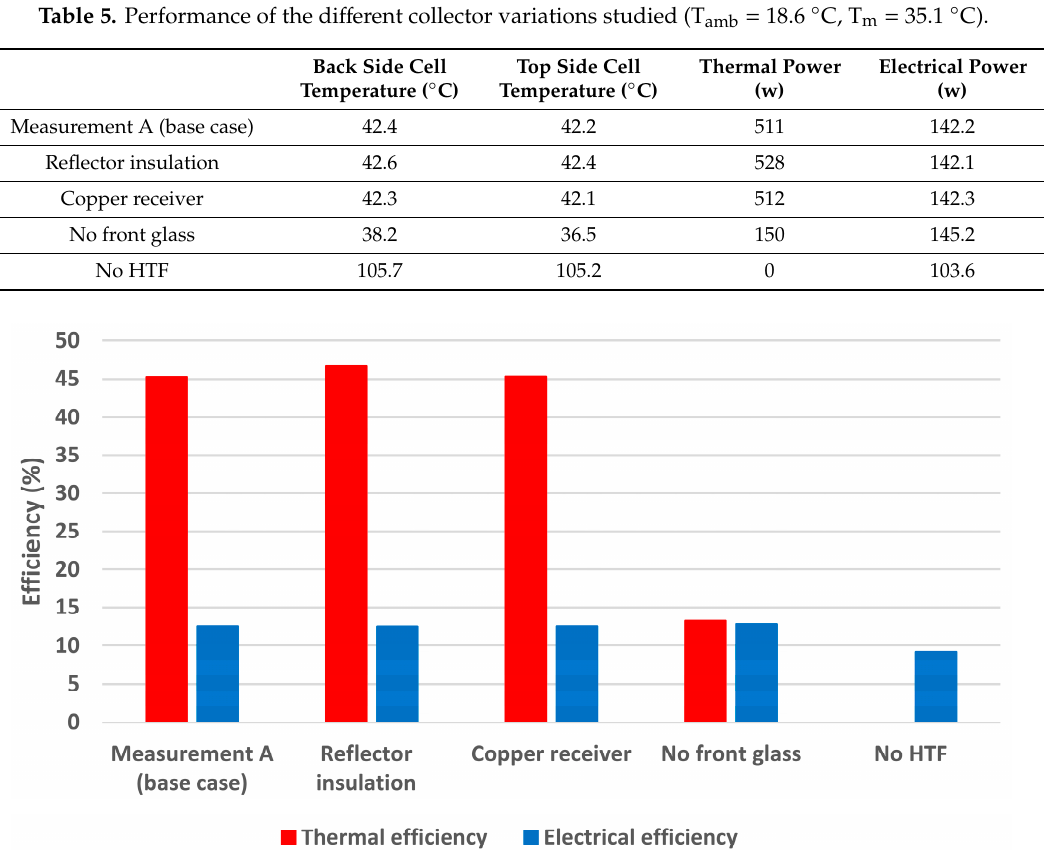
Table 5. Performance of the different collector variations studied (T amb = 18.6 °C, T m = 35.1 °C) .